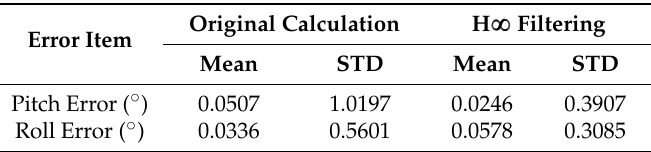
Table 1. Statistics of Angle Errors.